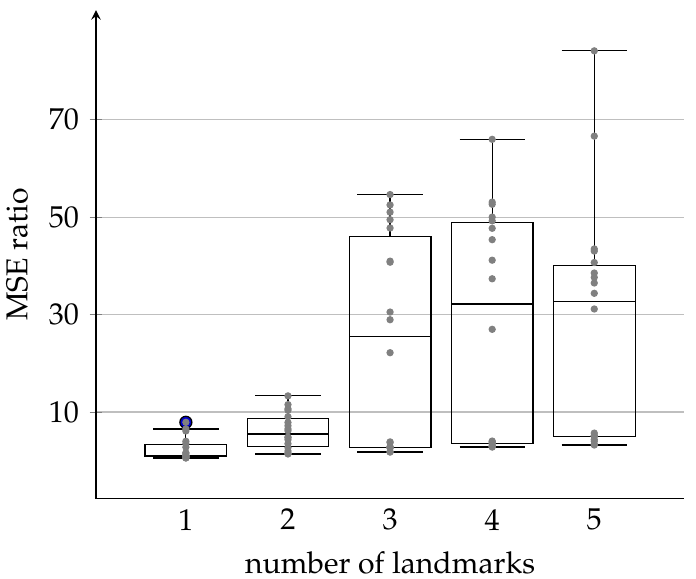
Figure 12. Statistics of the field tests for all possible combinations of datasets recorded in three different placements. Plots show clear increment of the MSE ratio with the increased number of the involved landmarks in the calibration process.